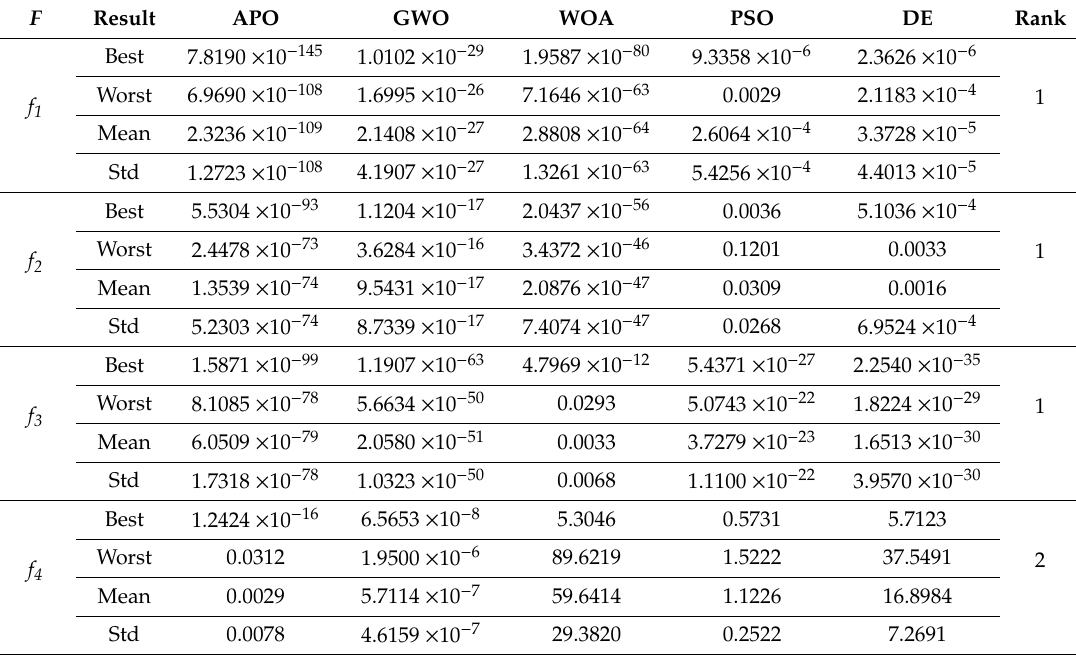
Table 5. Best, worst, mean, and SD obtained on functions from Table